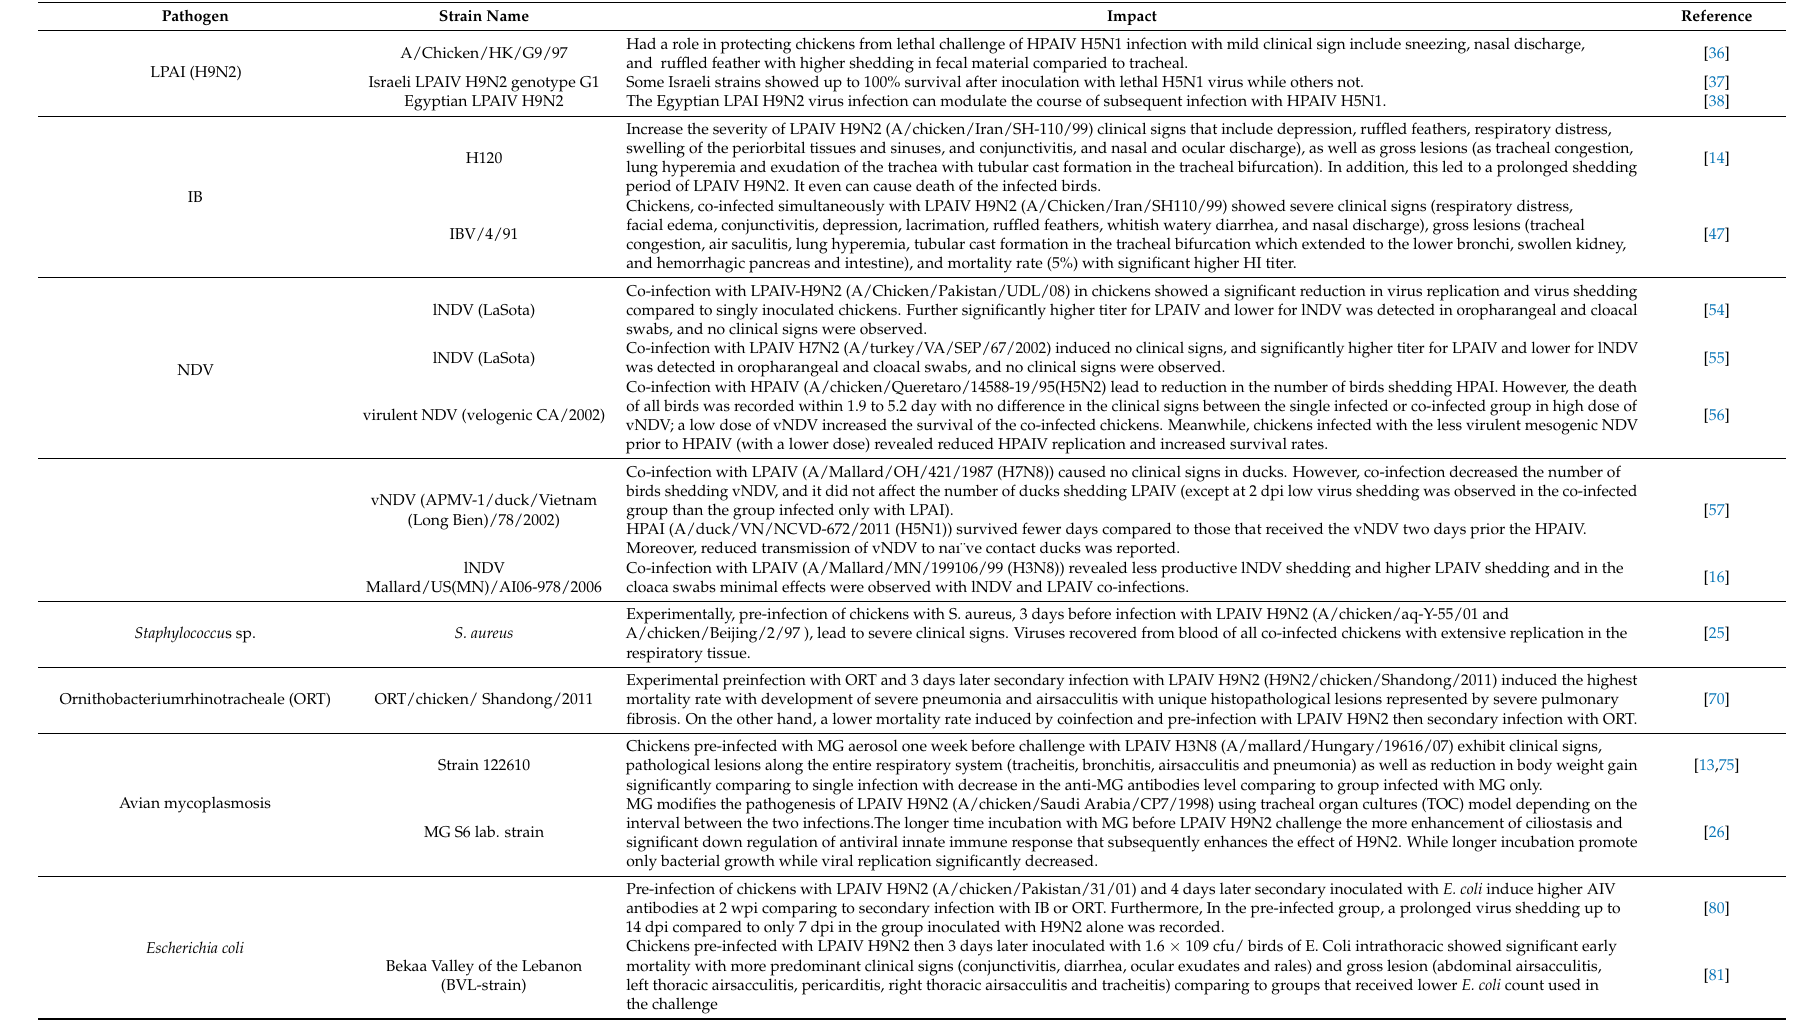
Table 1. Summary of the impact of co-infection/interference of different bacterial and viral pathogens on avian influenza viruses.